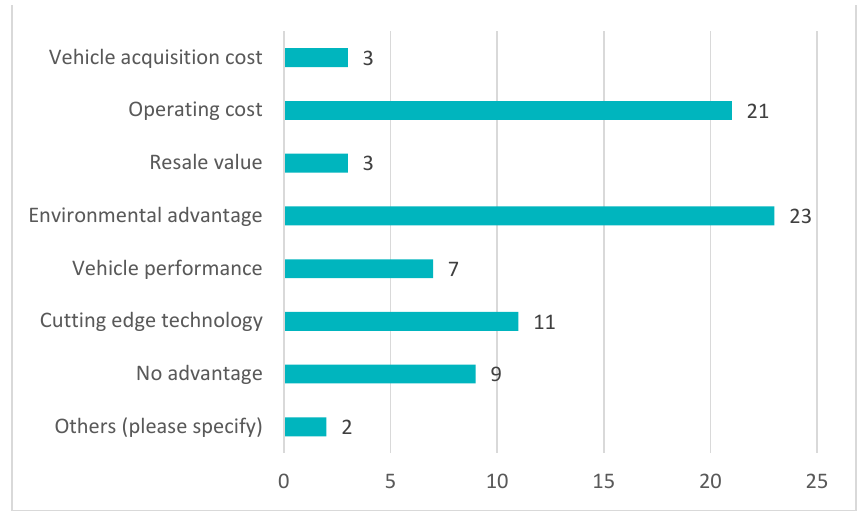
Figure 12. Perceived main advantages of an electric vehicle.